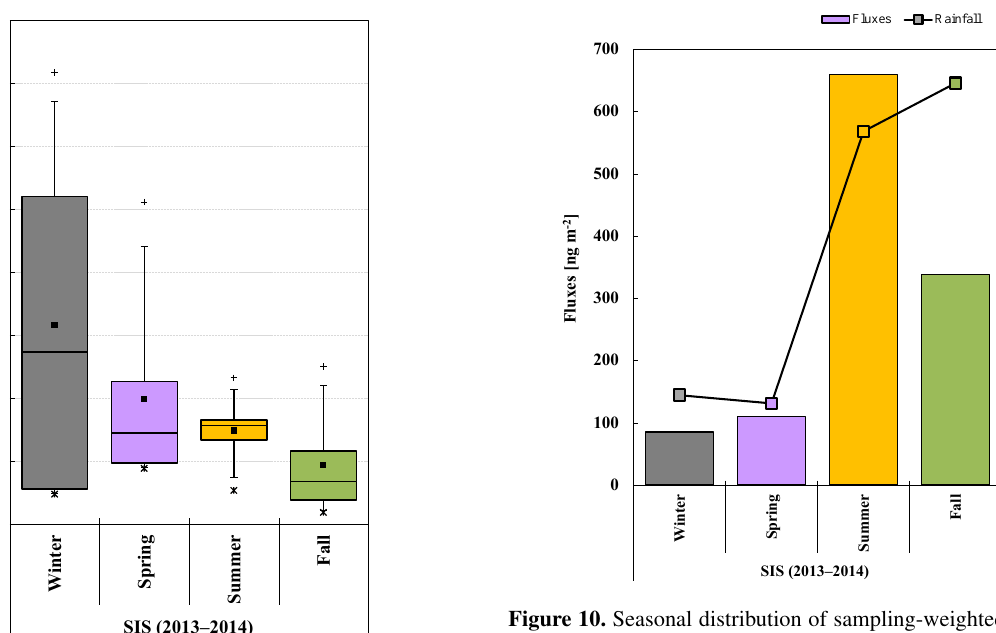
Figure 10. Seasonal distribution of sampling-weighted (by 15-day reference) fluxes at the tropical GMOS site (Sisal, Mexico) in 2013 and 2014. Each box includes the median (midline), mean ( (cid:4) ), 25th and 75th percentiles (box edges), 5th and 95th percentiles (whiskers), minimum ( ∗ ), and maximum ( +